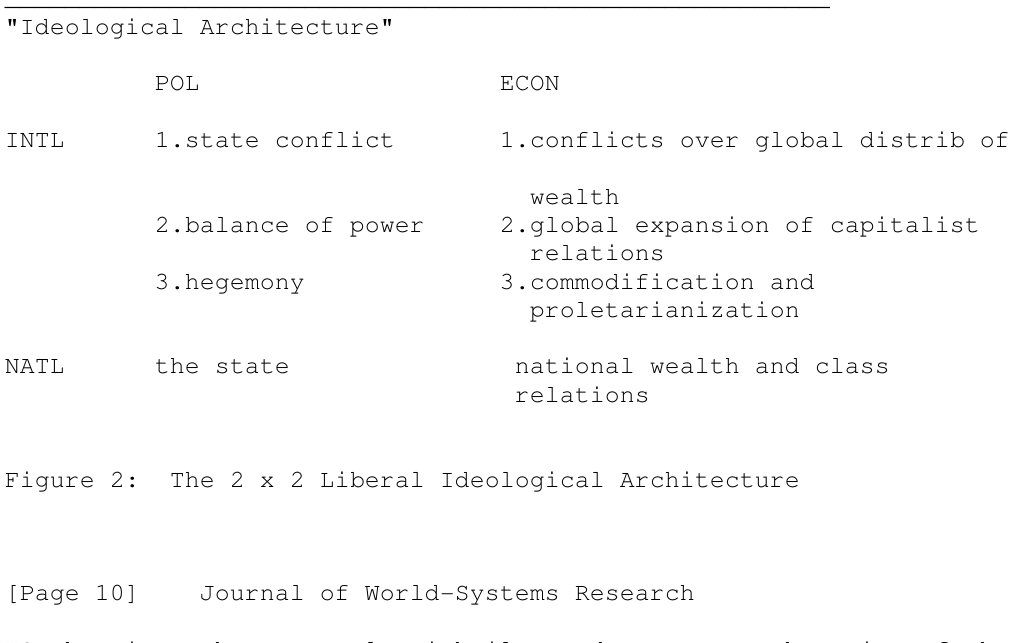
[Page 10] Journal of World-Systems